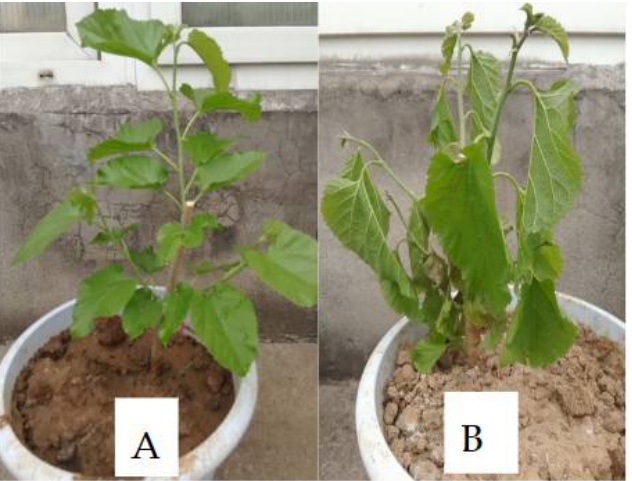
Figure 1. Physiological responses of mulberry leaves affected by drought and the control treatment.